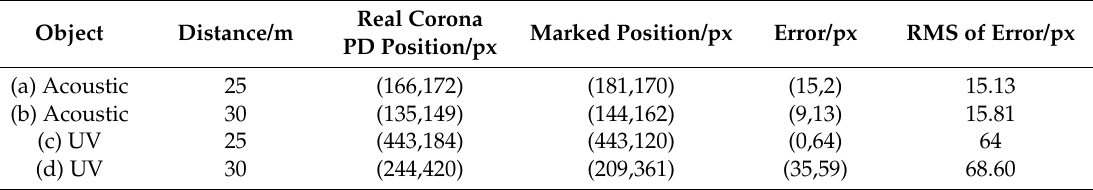
Table 4. Test results in the practical